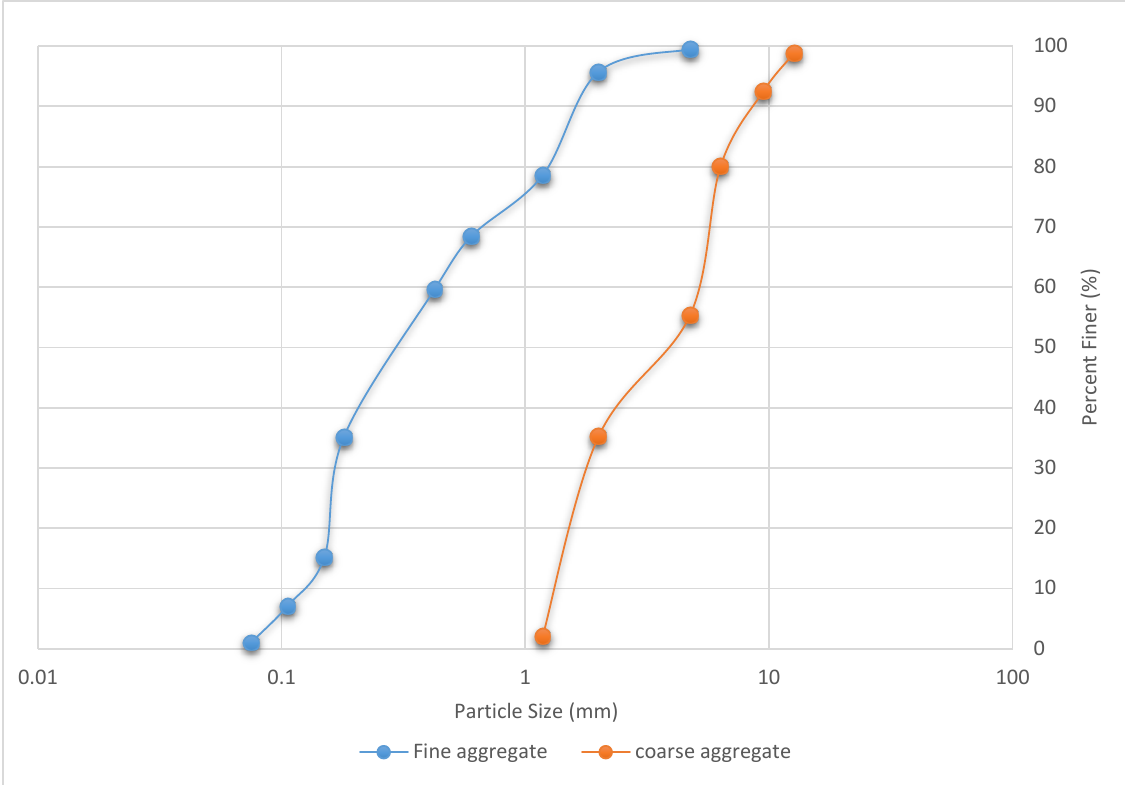
Fig 1. Grain Size Distribution of Aggregate